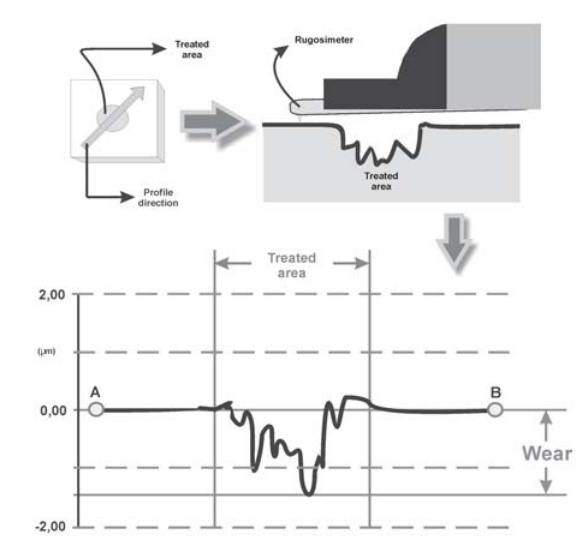
FIGURE 2- Schematic drawing demonstrating quantification of wear by the roughness